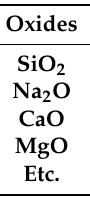
Table 1. Compositions of oxides from mirror